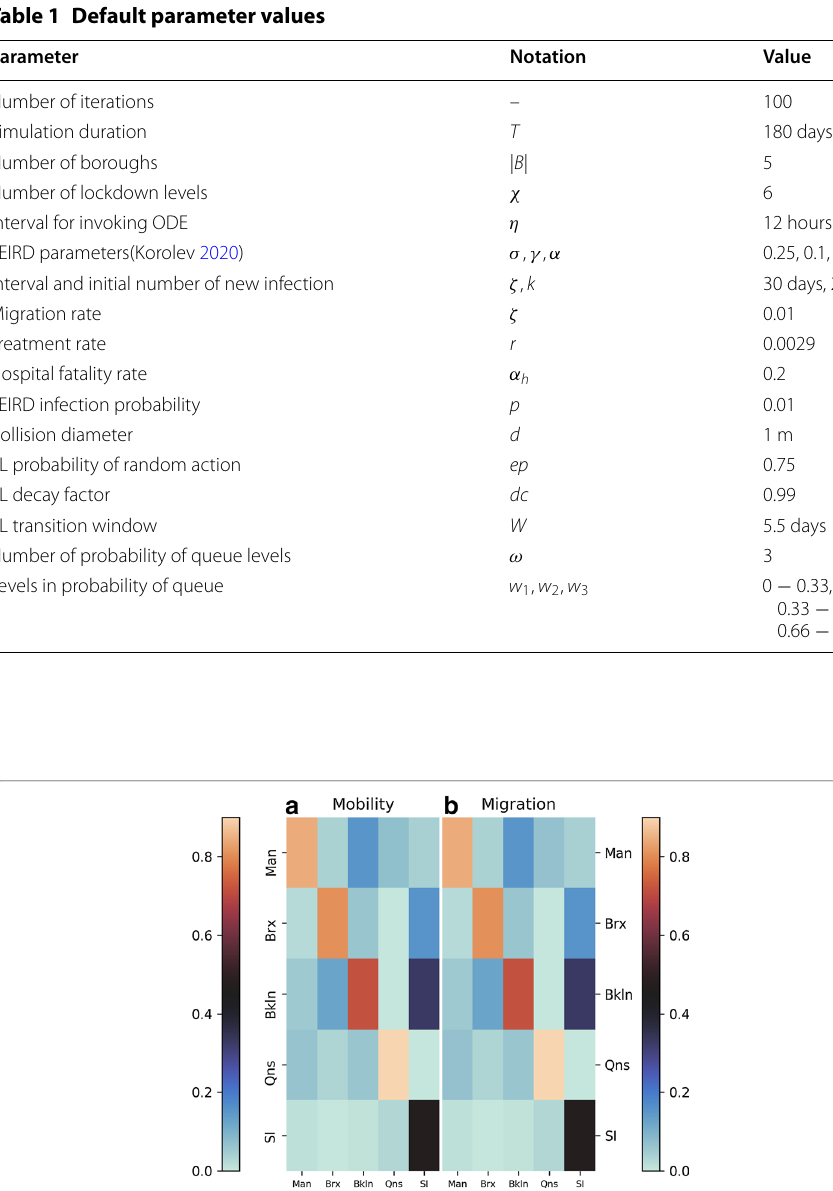
Fig. 2 Mobility: a the transition (or mobility) matrix based on NYC traffic data (Nycopendata 2020), and b the migration matrix produced by employing the inter-zone mobility